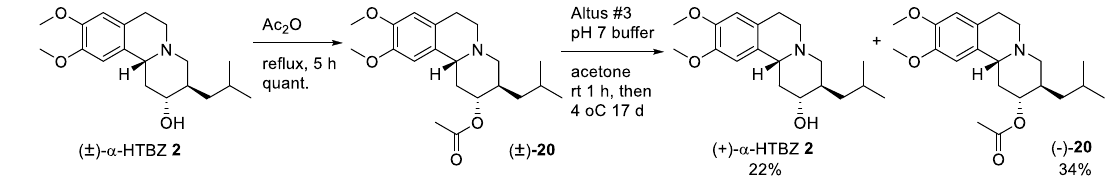
Scheme 4. The chiral separation of racemic α-HTBZ using enzymatic resolution.